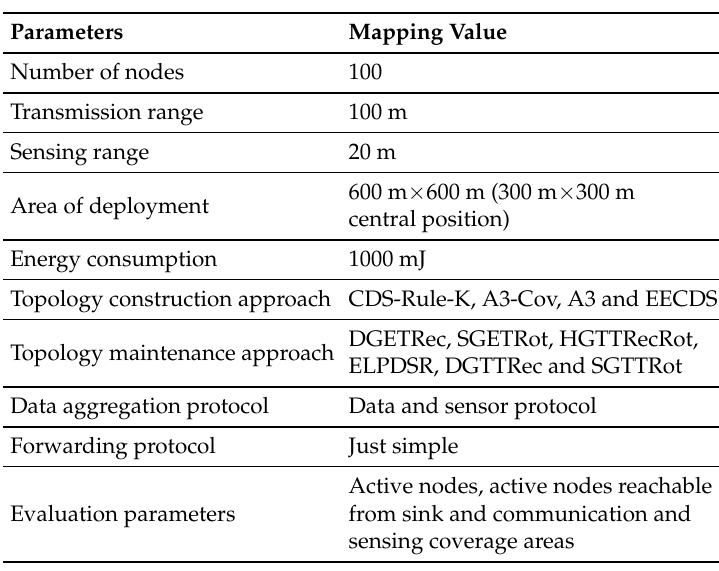
Table 3. Simulation setup for topology maintenance protocol.